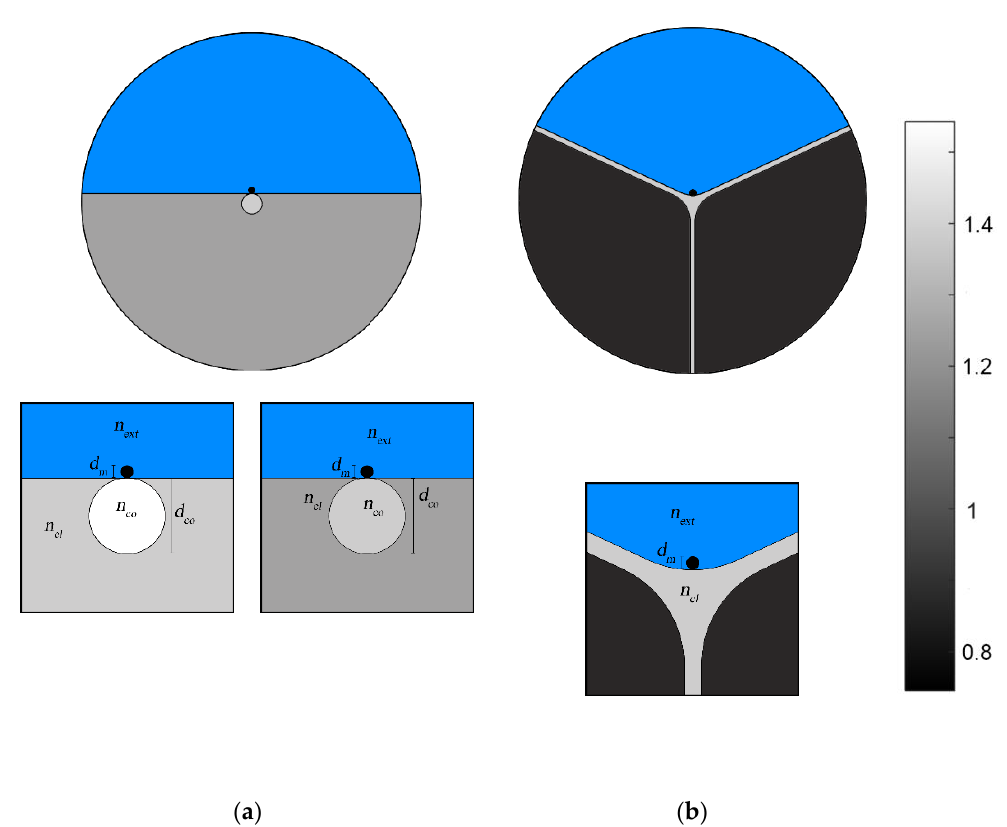
Figure 1. Structure designs of the two D-type fibers ( a ) and of the suspend core fiber ( b ), all of them with a gold wire placed in the upper space that is filled with external refractive index. To allow a better visualization of the refractive indexes involved in the three fiber configurations, a bar in the right side of the figure makes the correspondence of the greyscale to the refractive index.